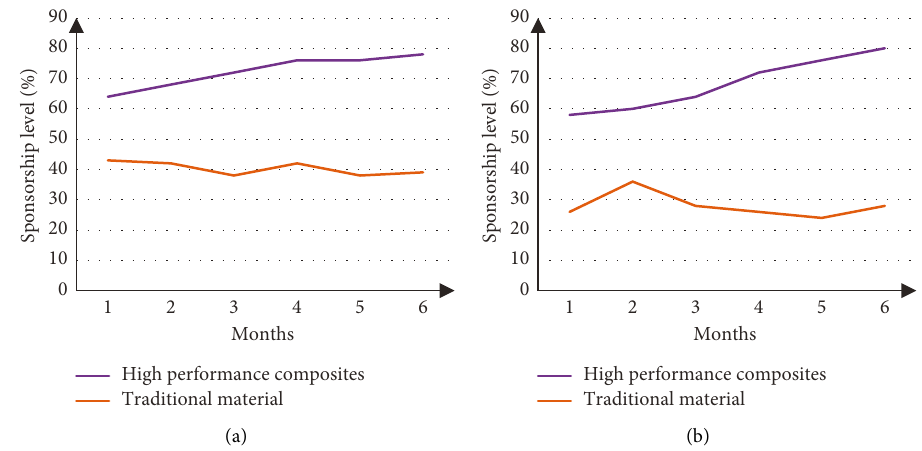
Figure 8: Results of sports brand sponsorship comparison. (a) Large-scale brands and. (b) Small-scale